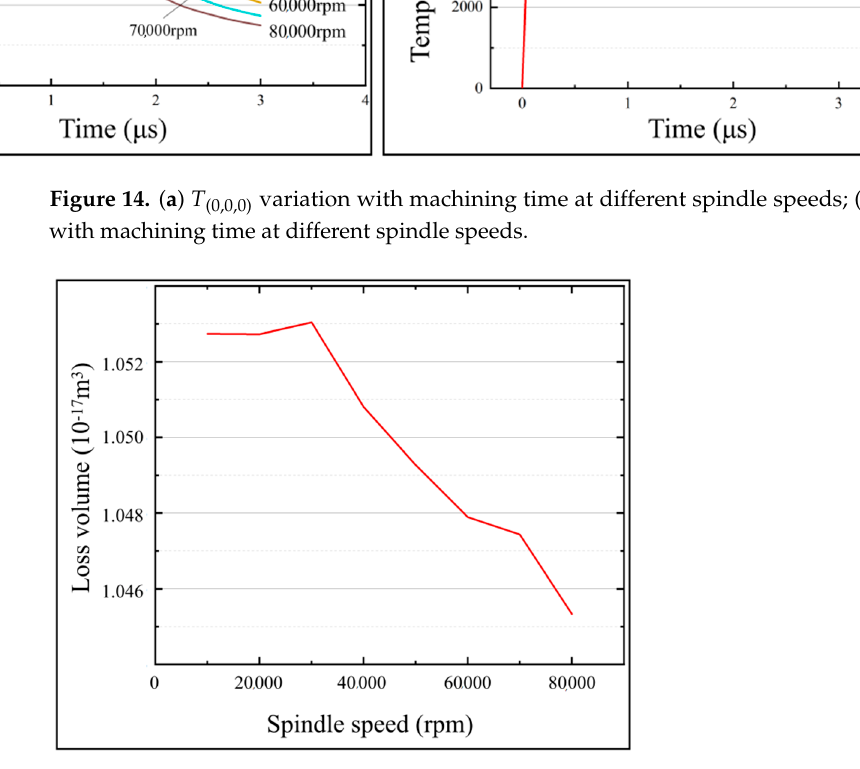
Figure 15. Micro-bit wear volume ( V m ) under different spindle